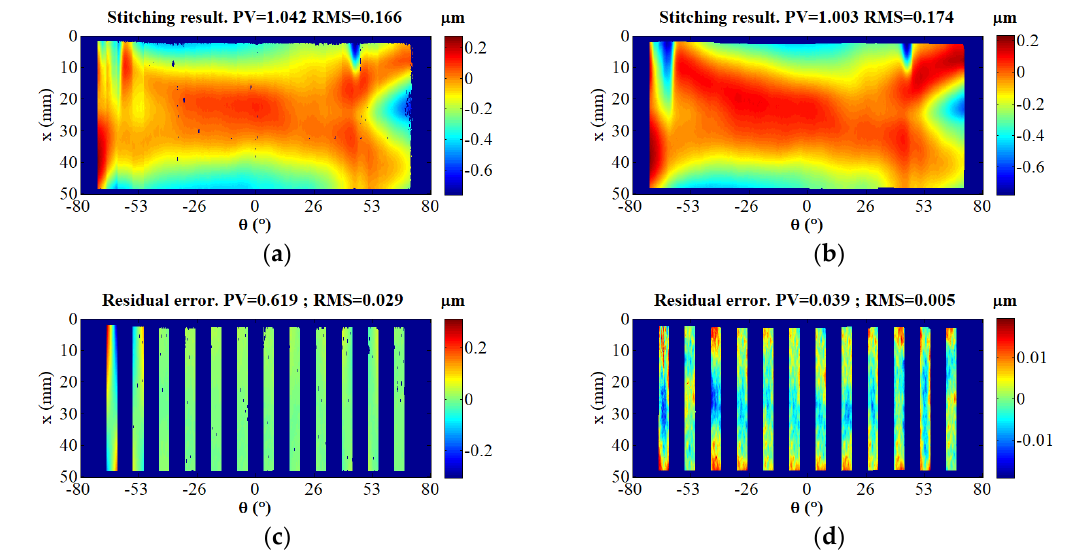
Figure 7. ( a,b ) Stitching result without iteration and the mismatch map; ( c,d ) comparison with the proposed method with three iterations.